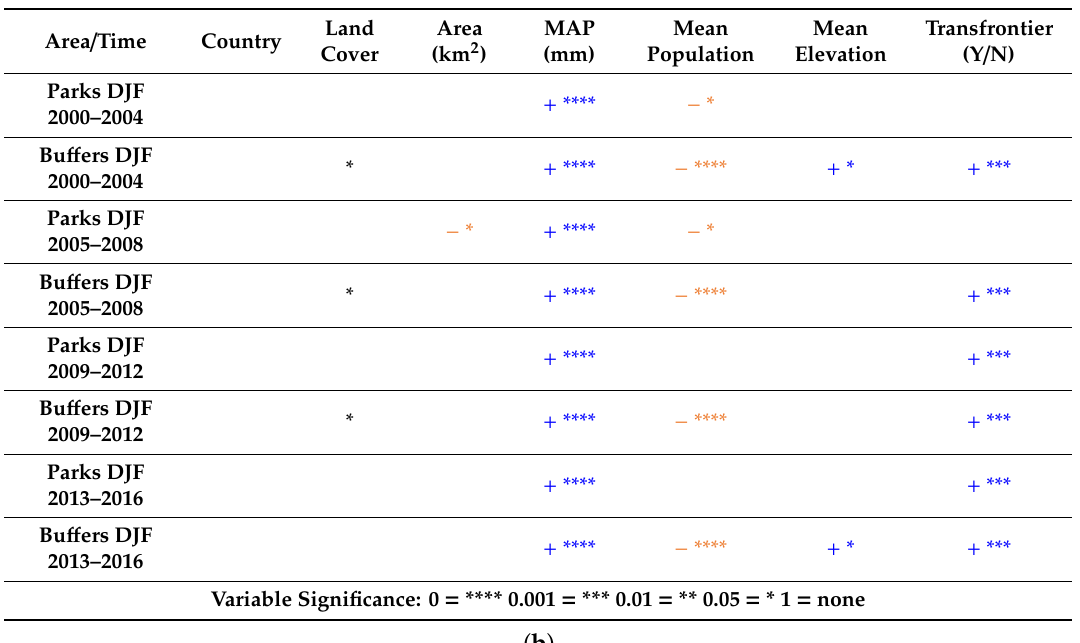
Table 2. Stepwise backward regression results for parks and bu ff ers in ( a ) December, January, February and ( b ) March, April, and May at each of the time periods 2000–2004, 2005–2008, 2009–2012, 2013–2016 including each model independent variable: country (X1), land cover (X2), area (X3), mean annual precipitation (X4), human population (X5), elevation (X6), and transfrontier (X7 and n = 31 of the 79 parks), positive or negative relationship between the dependent and independent variable (if applicable), and the level of significance of the relationship between the dependent and independent variable. Variable significance is designated by asterisks. More asterisks indicate higher significance: 0